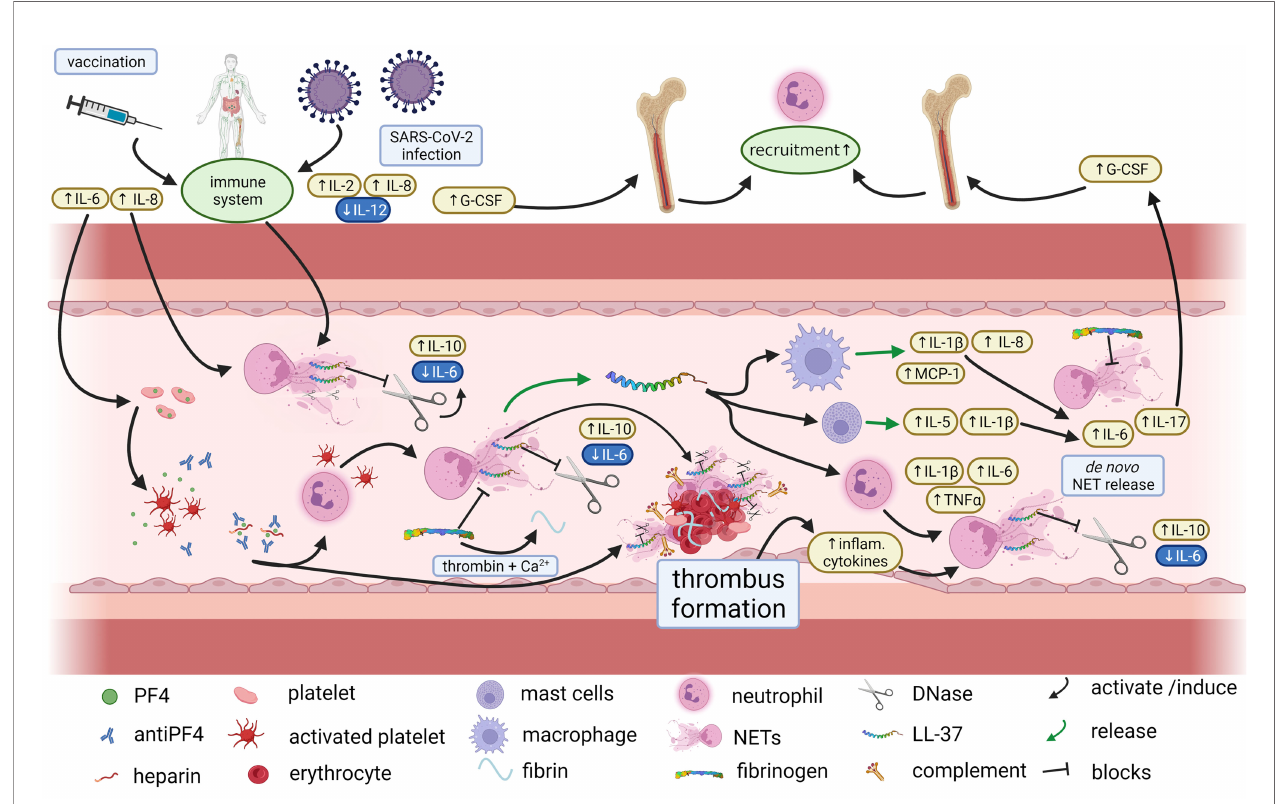
FIGURE 8 | Proposed immunothrombotic mechanisms during VITT. Proposed interplay between cytokines and NETosis in VITT, Vaccination against SARS-CoV-2 may trigger the immune system and in particular NETosis as well as platelet activation by antiPF4 antibodies. NETosis is counter regulated by DNases which however may be blocked e.g. by LL-37. As a result, and under conversion of fi brinogen to fi brin excessive thrombus formation may occur with embedded NET markers, complement factors, LL-37 and DNase. The thrombus formation induces a subsequent in fl ammatory response which further contributes to NETosis in terms of a vicious cycle. Thus, an impaired ef fi cacy of endogenous NET-regulation may be an important contributor to severe thrombotic complications of VITT (created with